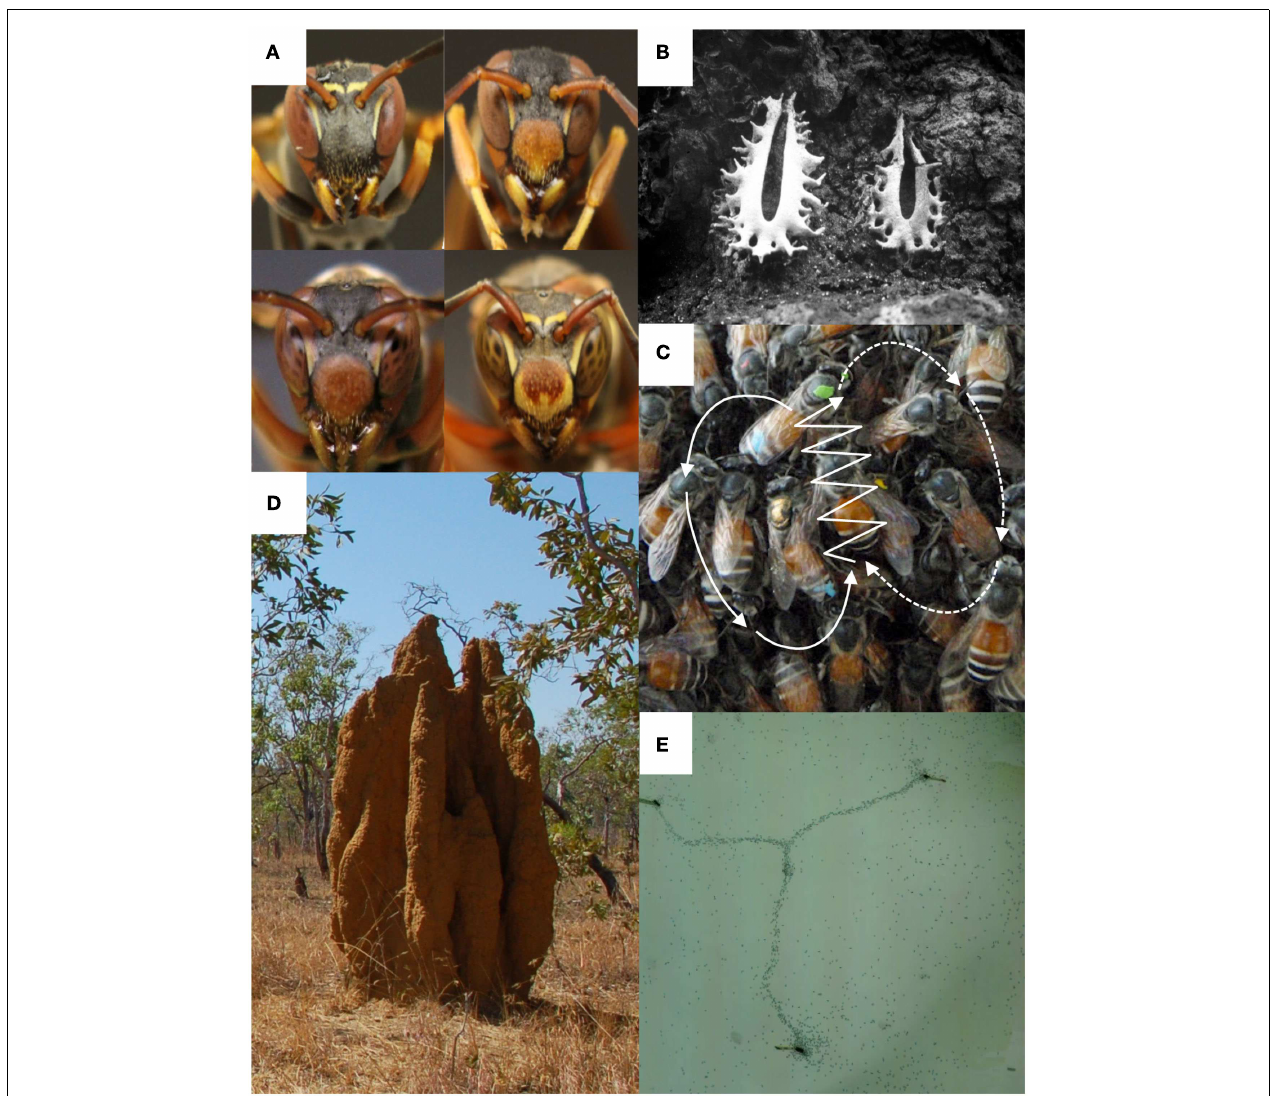
performs a figure-of-eight-shaped circuit (white arrows) conveying information about the distance (duration of the waggle phase) and the direction (body orientation relative to gravity) of the target resource (photo J. Makinson). (D) The Australian termites Nasutitermes triodiae build complex “cathedral” nests several meters high containing multiple chambers.Walls and pillars arise through the action of many termites, each depositing soil pellets at sites scented with an attractive cement pheromone, which coordinates the accumulation of building materials without any individual having a global knowledge of the construction process (photo S. Scheurer). (E) Argentine ants Linepithema humile develop pheromone transportation networks to connect the multiple nests of the colony. Collectively, ants establish near optimal networks using pheromone trails as an “externalized memory” (photoT.